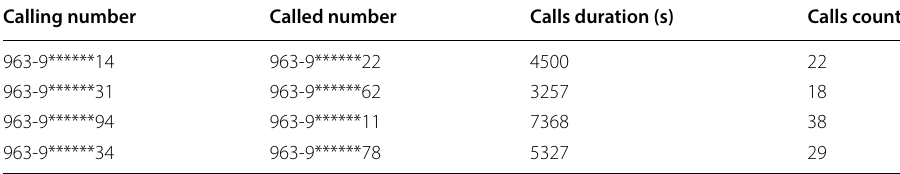
Table 3 Sample of summarized